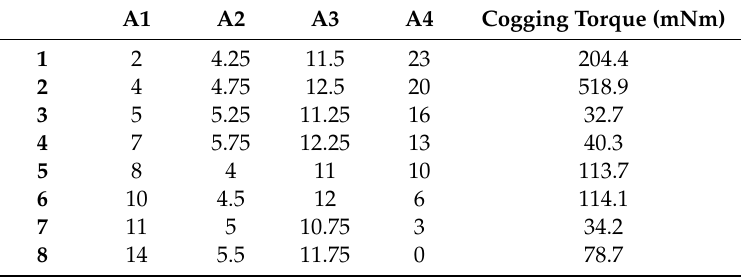
(cid:16) (cid:17) 8 5 8